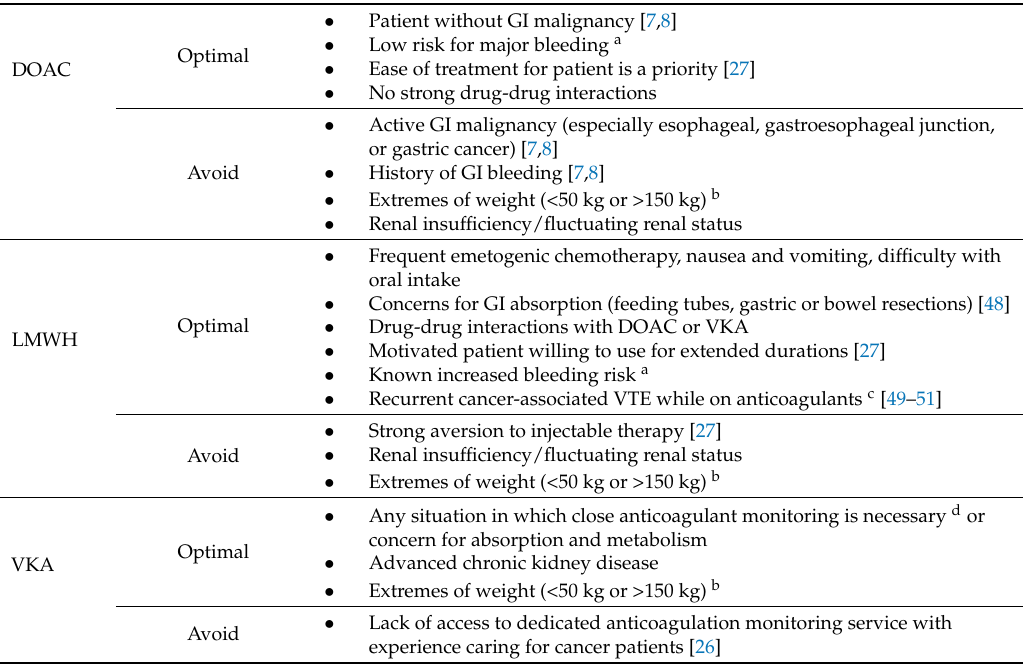
Table 3. Recommendations for use of each class of anticoagulant for treatment of cancer-associated VTE.